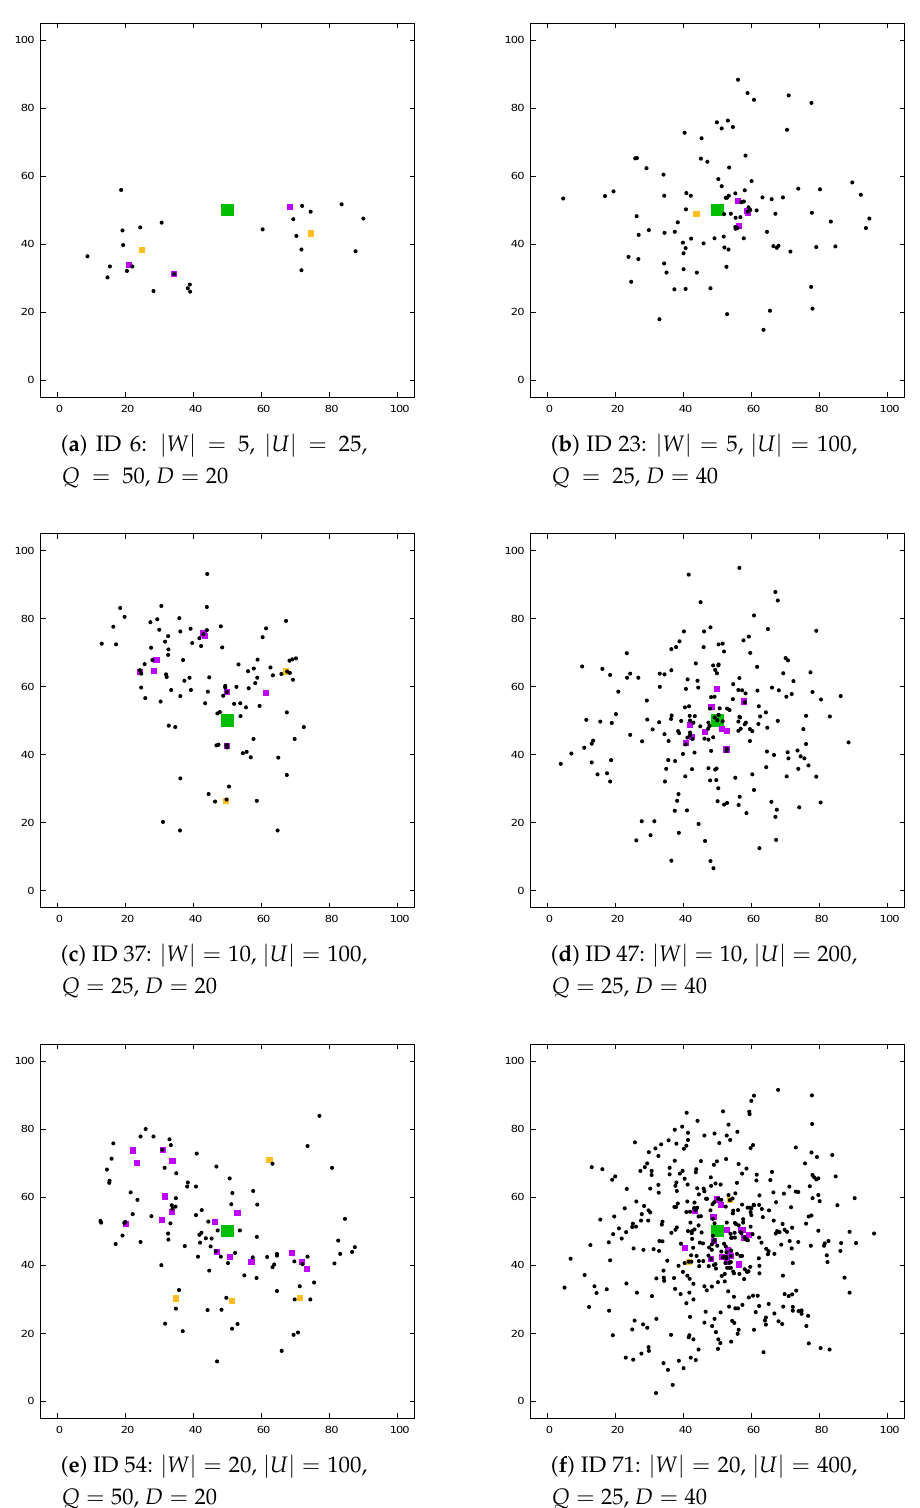
Figure 4. Geographical distribution of six instances. The green square represents the depot. The remaining squares represent bus stops. The yellow squares are the fixed stops. The black balls correspond to